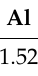
Table 1. Grade 37 titanium (ATSM B 265) chemical composition in wt%, Ti = bal.